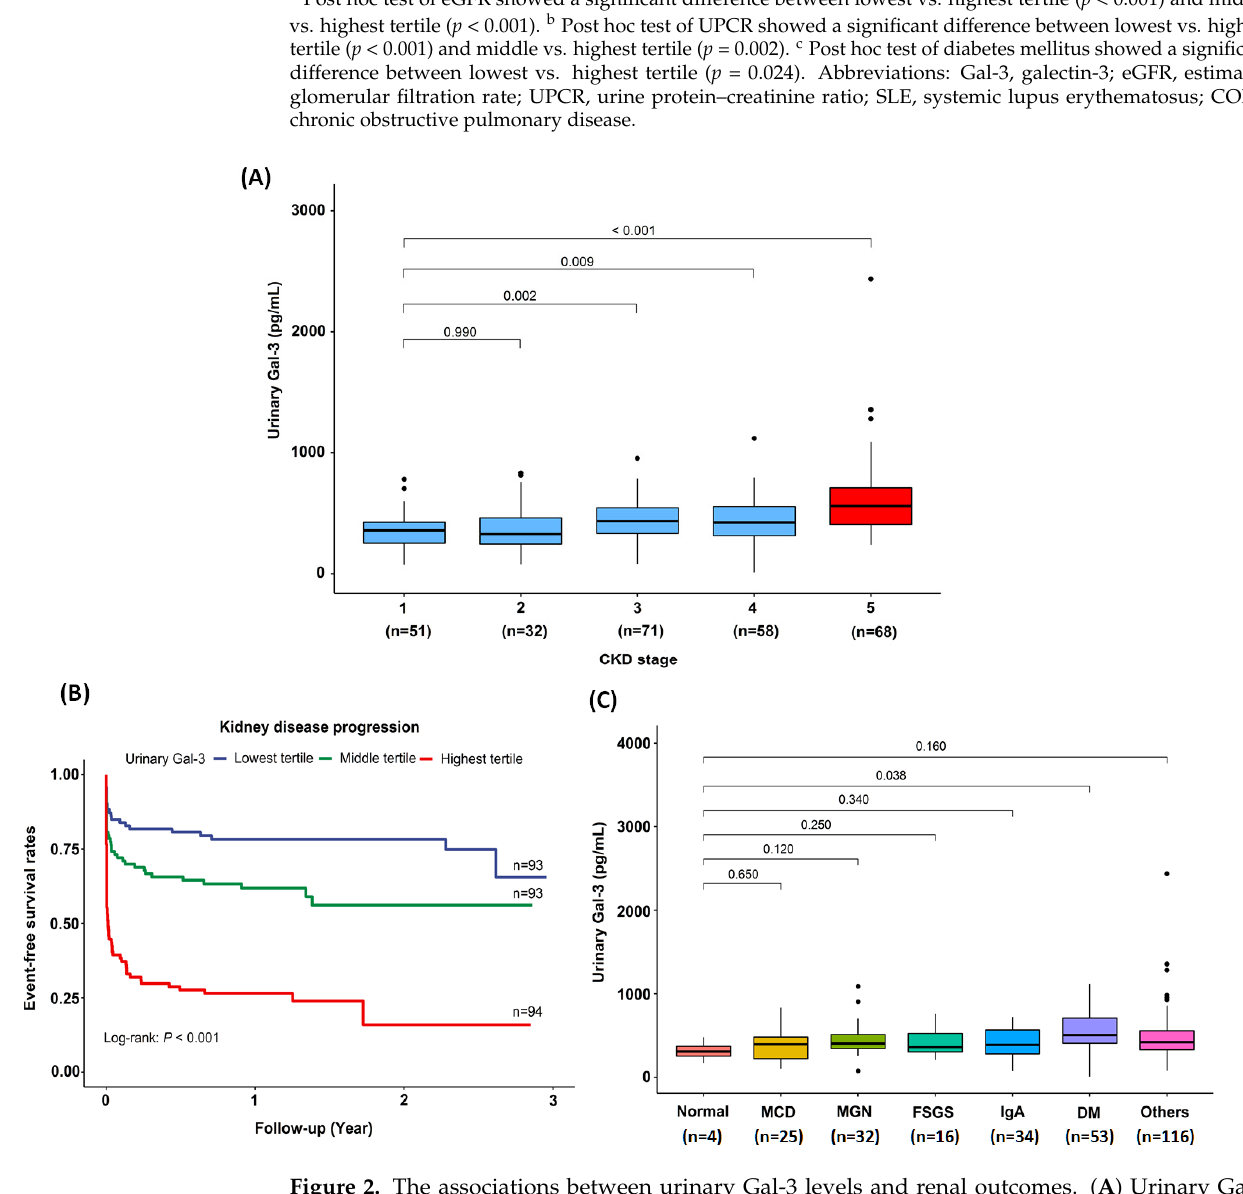
Table 1. Cont. All Patients